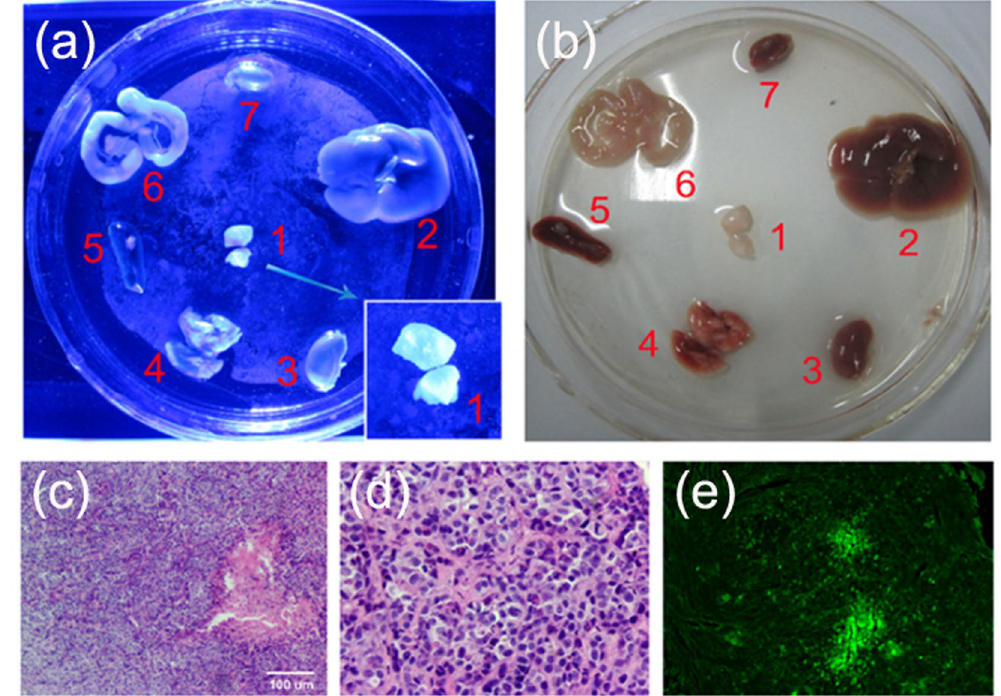
Figure 7. ( a ) and ( b ) Representative images of dissected organs of amouse bearing HEPG-2-induced tumors. The mouse was sacrificed and organs were removed and incubated with 100 μ M of 1 for 5 hours under hypoxic conditions. 1. HEPG-2 tumor; 2. lung; 3. liver; 4.kidney; 5. spleen; 6. intestine; 7. heart. ( c ) H&E staining of murine sarcoma HEPG-2-induced tumor ( × 100). ( d ) H&E staining of murine sarcoma HEPG-2-induced tumor ( × 400). ( e ) Immunofluorescence of HEPG-2 tumor by Glypican 3